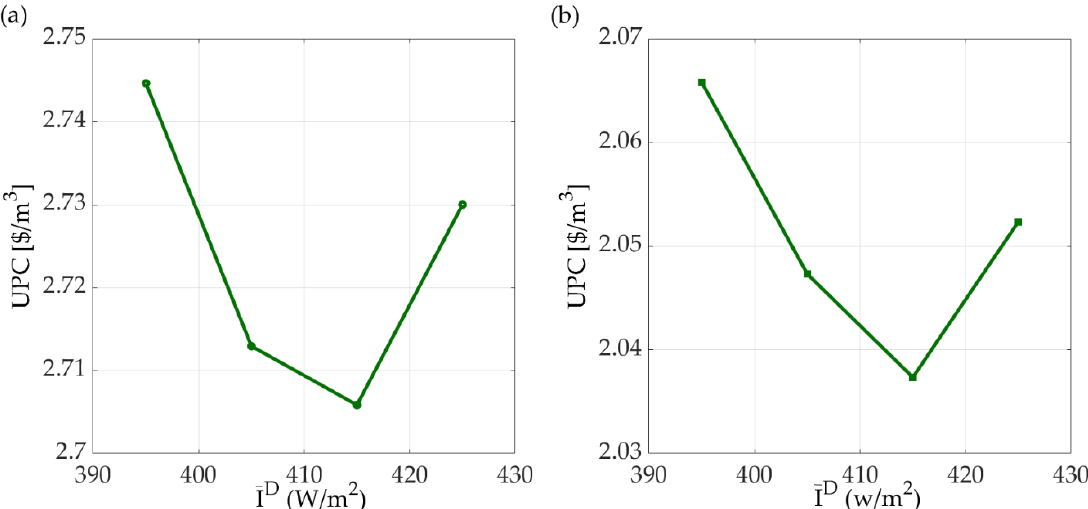
Figure 10. The unit water production cost of the solar-driven AGMD system for desalination with a membrane unit cost of ( a ) $90/m 2 ( b ) $36/m 2 .